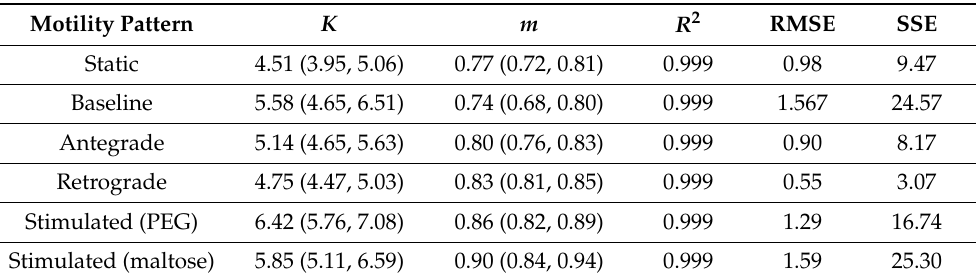
Figure 5. Cumulative release profiles in the DCM under different motility patterns. The shaded regions represent the 95% confidence interval around the mean value predicted by the model (Table 4). Table 4. Power law model fitted to release profiles in the DCM under different motility patterns. The constants are presented as mean (95% confidence interval) and relevant regression statistics are presented including root mean square error (RMSE), adjusted correlation coefficient (Adj. R 2 ) and standard square error (SSE).